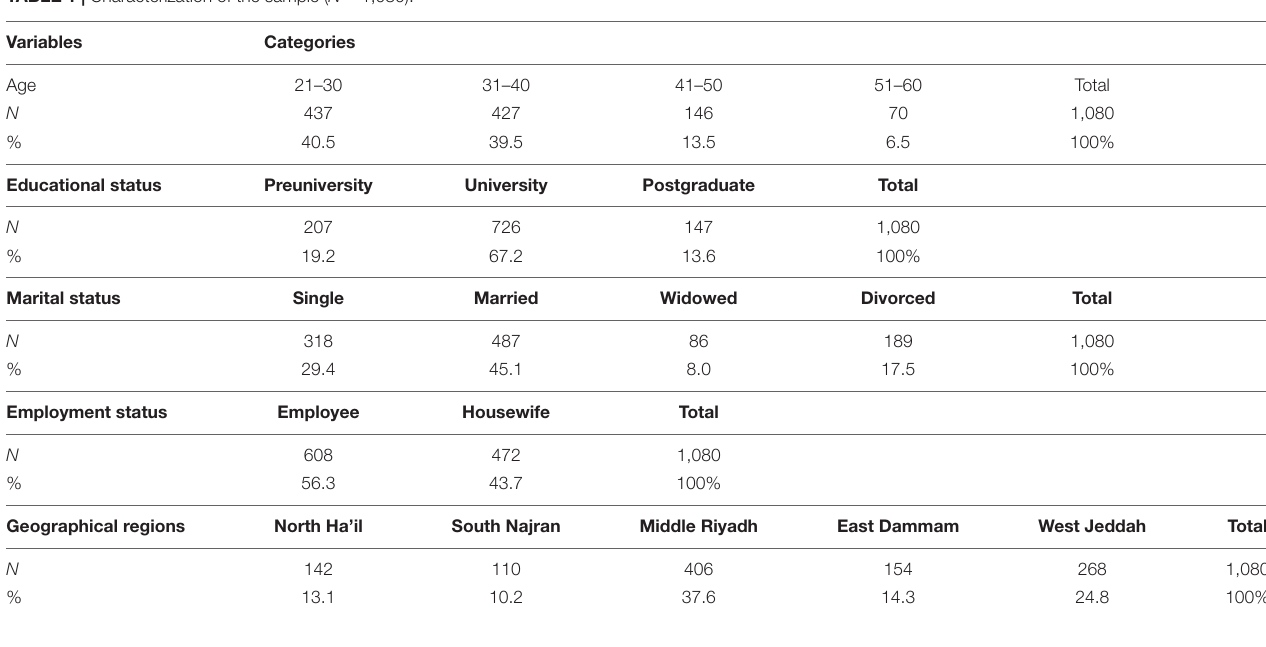
TABLE 1 | Characterization of the sample ( N =